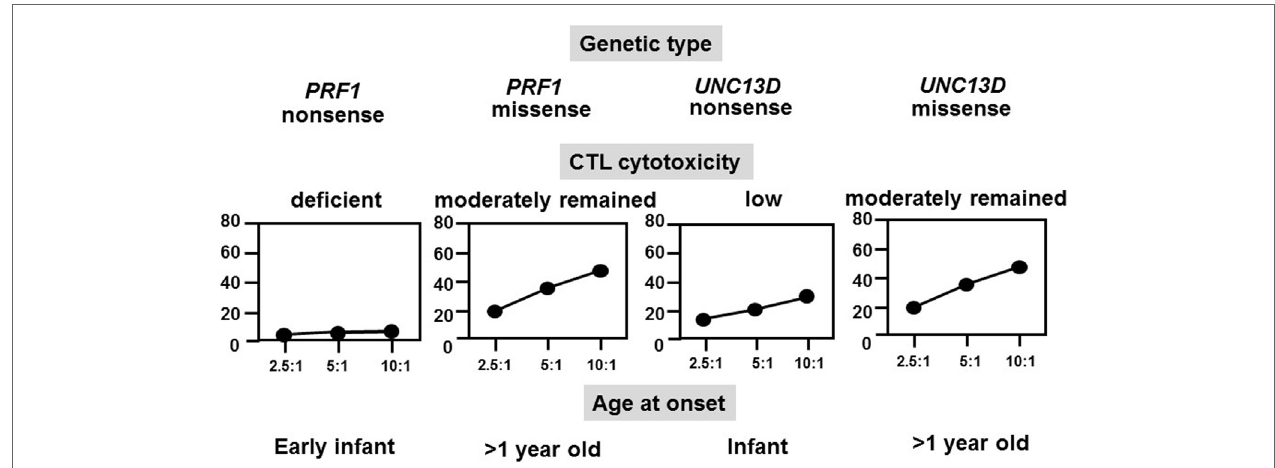
FiGURe 3 | Correlation among genetic subtype, CTL activity, and age at onset of FHL . The cytotoxicity of CD8 + T-cell lines that were generated from patients with different FHL subtypes was determined. Cytotoxicity was deficient in patients with FHL2 having PRF1 nonsense mutations and was very low in patients with FHL3 having UNC13D nonsense mutations but was moderate in those with missense